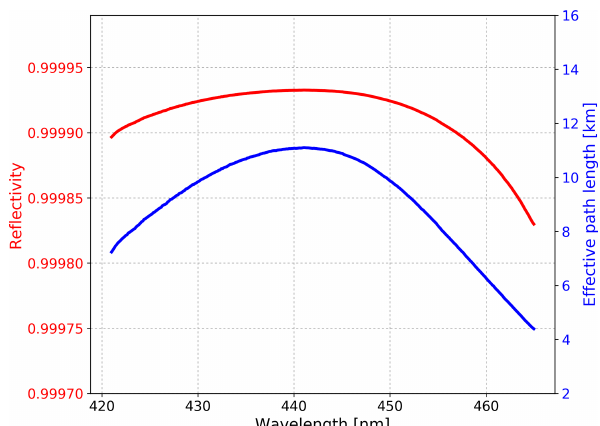
Figure 3. Mirror reflectivity calibrated with high-purity nitrogen (>99.999%) and helium (>99.999%) and corresponding effective path length during the YRD